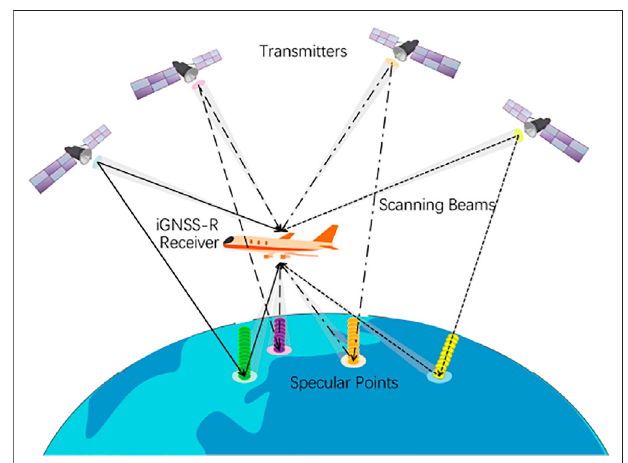
FIGURE 1 | Scheme of the airborne iGNSS-R altimeter theoretical